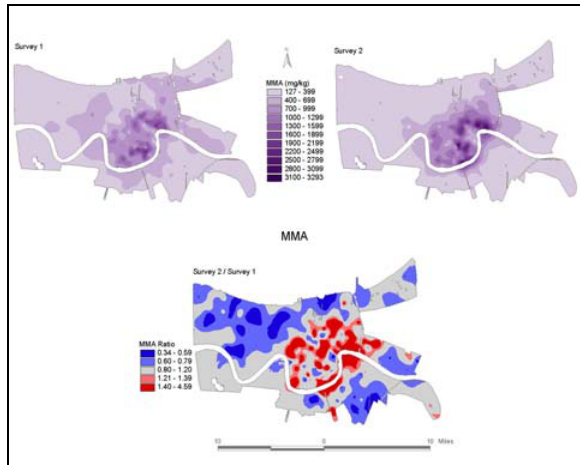
Figure 1: Preliminary MMA maps of New